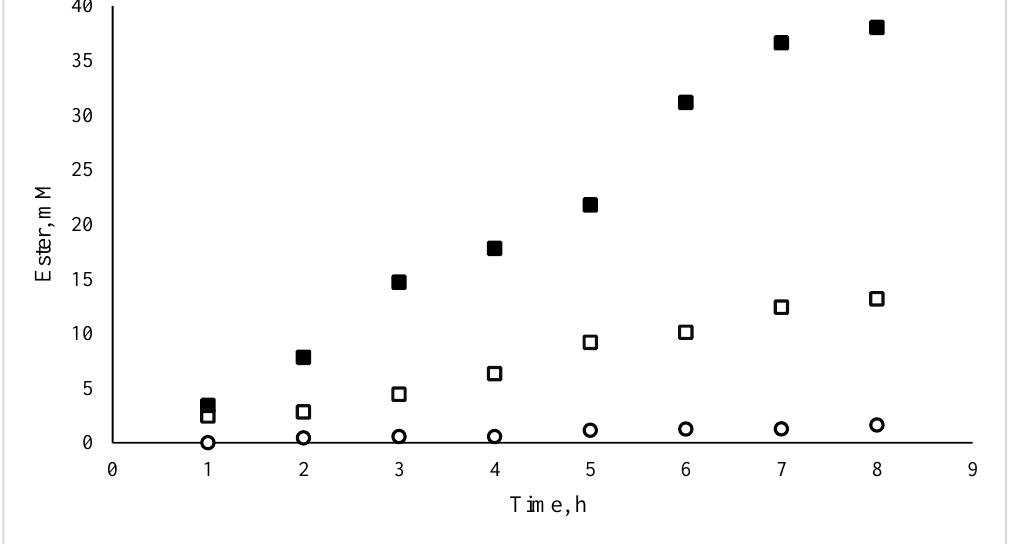
Table 1. Weight composition of the studied HPMC-based